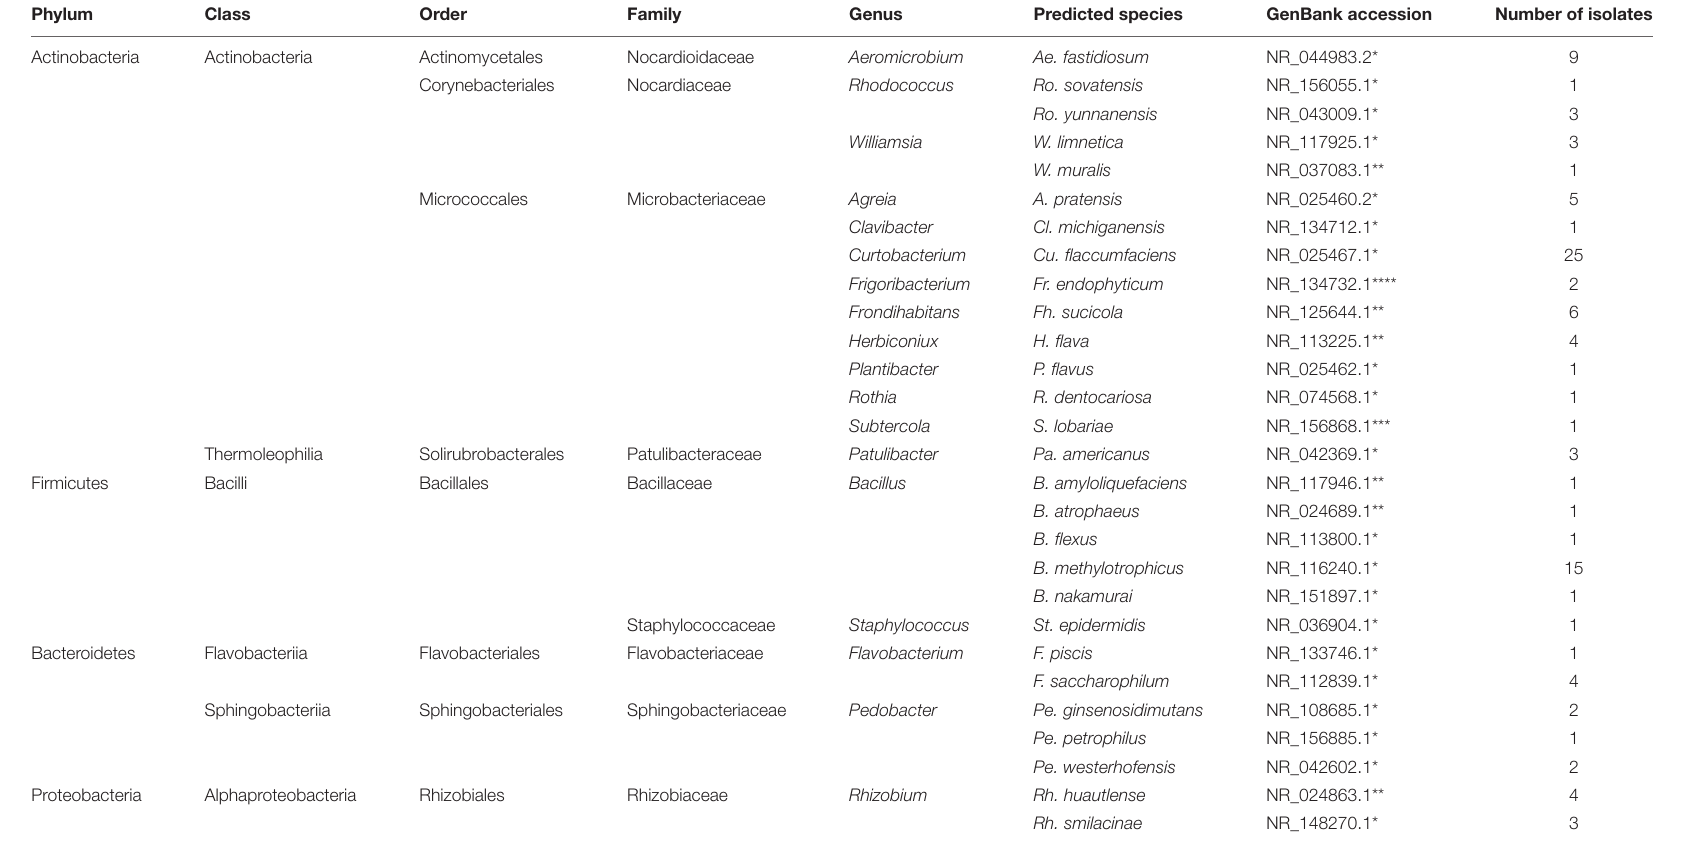
TABLE 2 | Identified bacterial isolates from wild apple stems by 16S RNA sequence analysis and their taxonomic status.